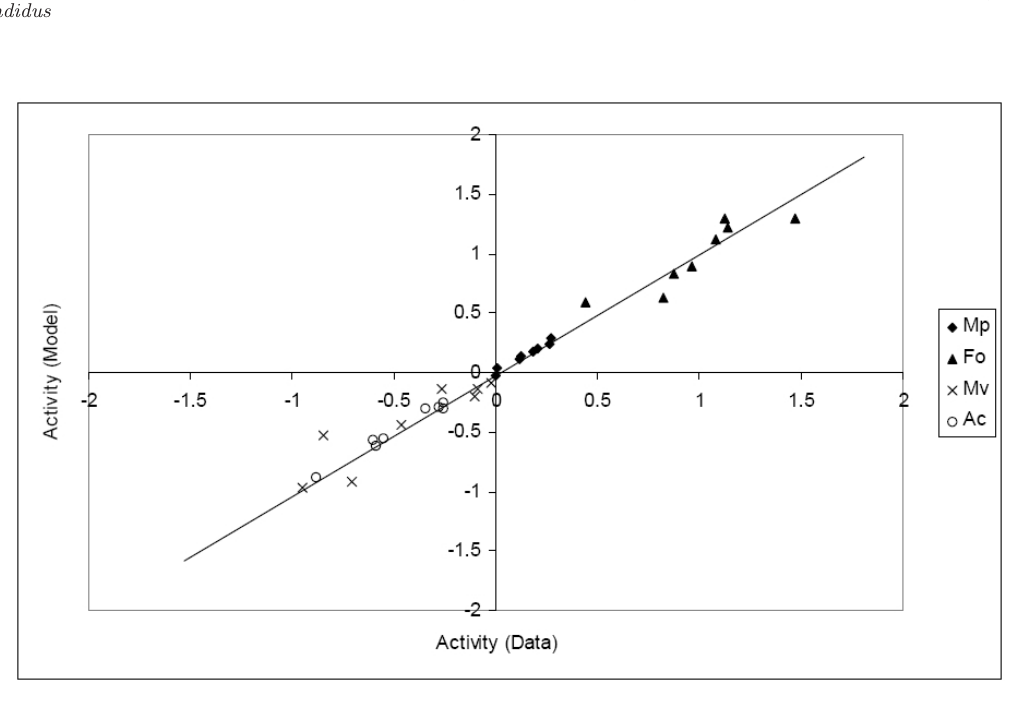
Fig. 3 Parity plot relating model predictions with experimental data against four fungi.